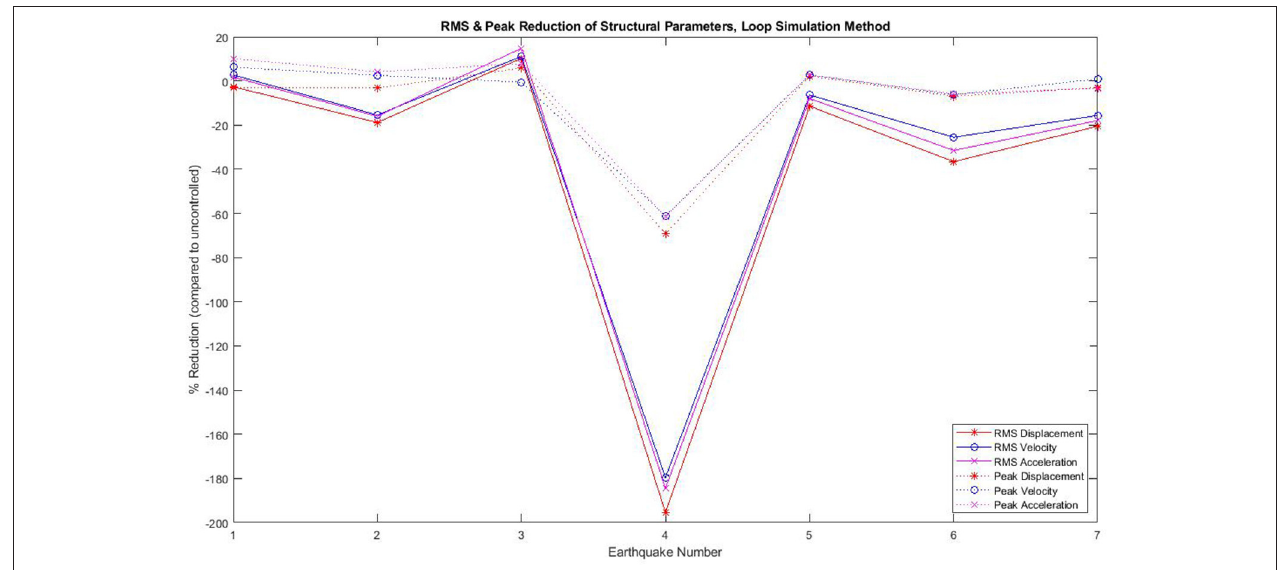
FIGURE 14 | Results for all ground motion records showing reductions to key structural parameters (obtained through loop simulation